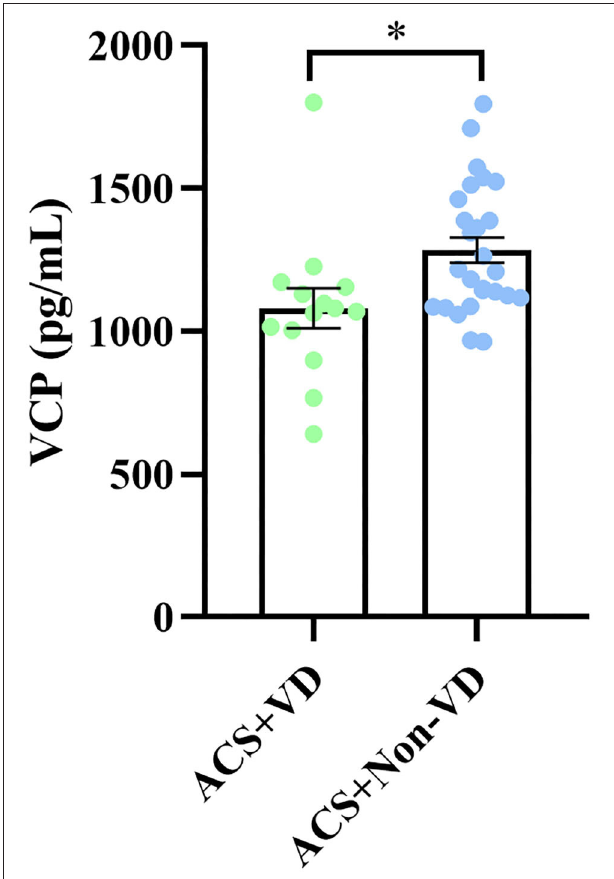
Frontiers in Cardiovascular Medicine |